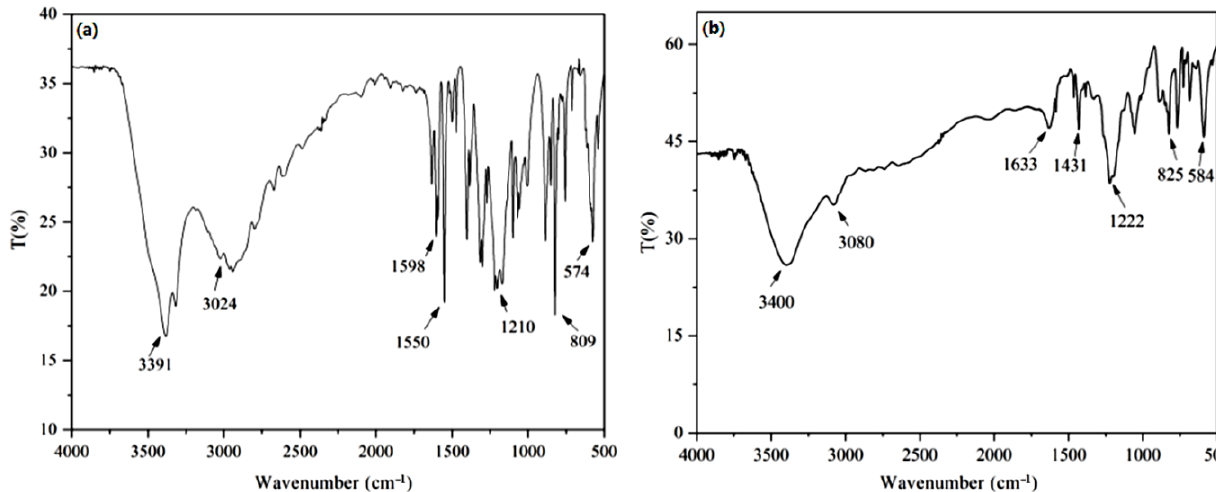
Figure 1. The IR spectra of [HHqu][HSO 4 ] ( a ) and [HBth][HSO 4 ] ( b ). Table 2. FI-IR spectra analysis of [HHqu][HSO 4 ] and [HBth][HSO 4 ].